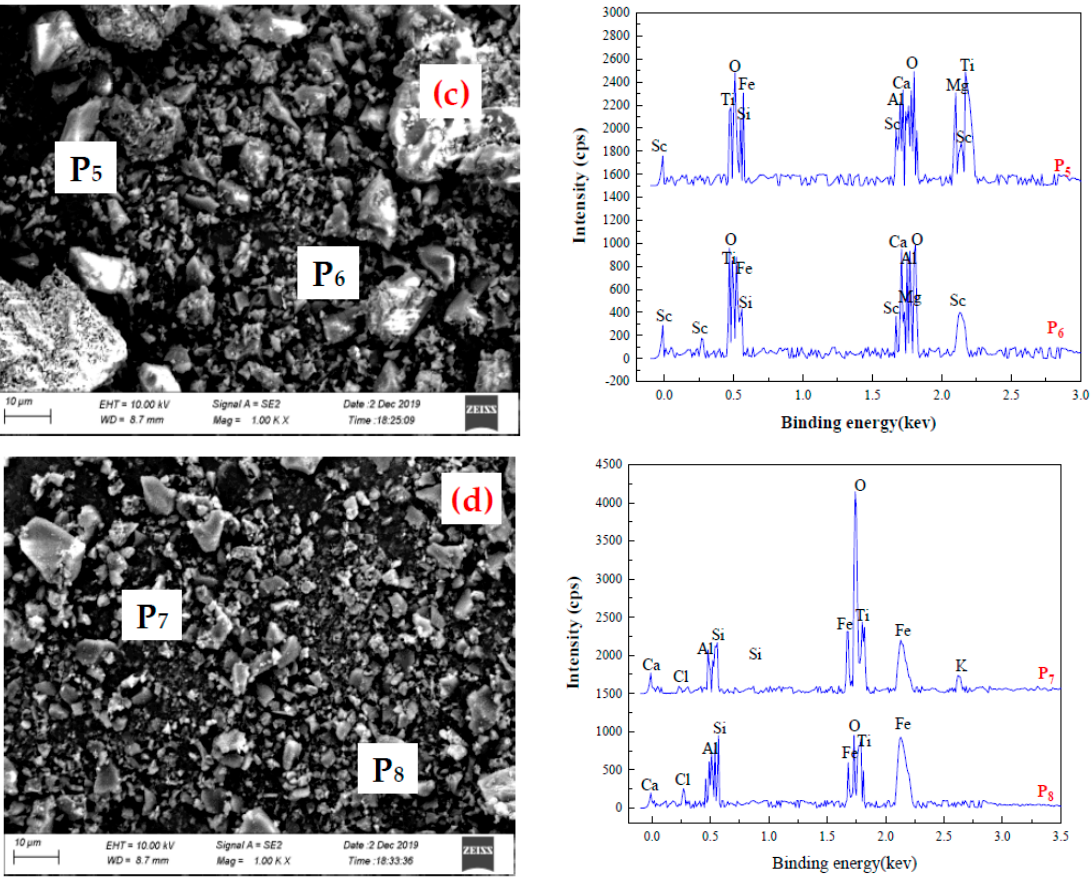
Figure 8. SEM-EDS images analysis results ( a ) scandium rough concentrate, ( b ) roasting ores, ( c ) hydrolysis residue, ( d ) leaching residue.